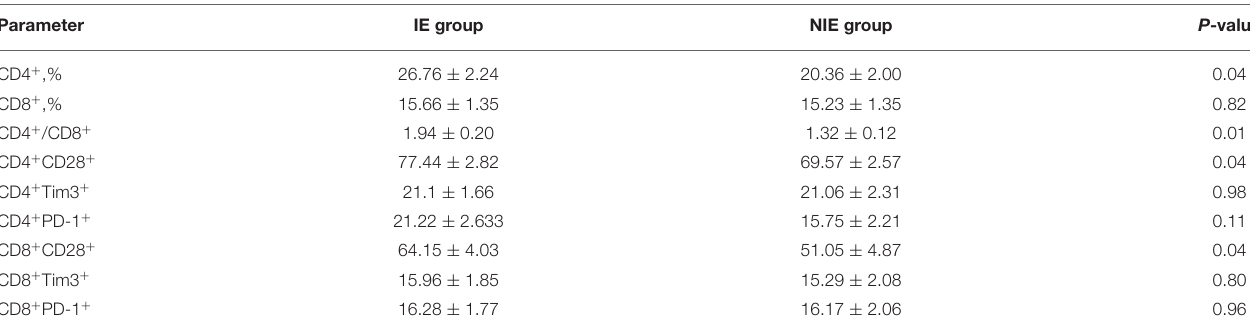
TABLE 2 | Changes of immune indicators in the NIE and IE